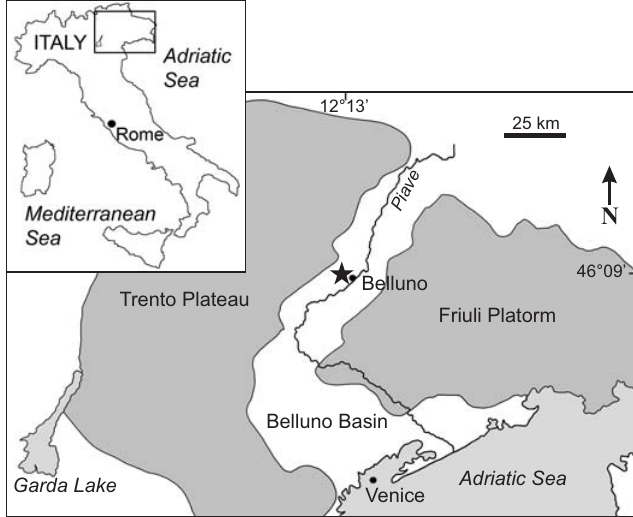
Fig. 1. Geographic location of Cavar zano, Valle delle Guglie, near Belluno, Italy (modified after Bosellini et al. 1981 and Dallanave et al. 2009). Asterisk indicates estimated type locality of Italosiren bellunensis